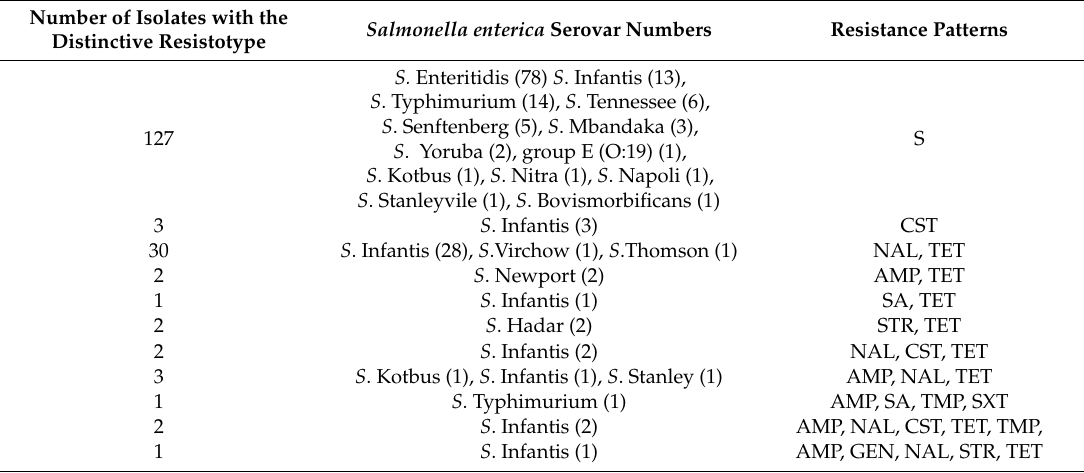
Table 1. Antimicrobial susceptibility of Salmonella enterica isolates from poultry (excluding S . Enteritidis), Republic of Serbia.